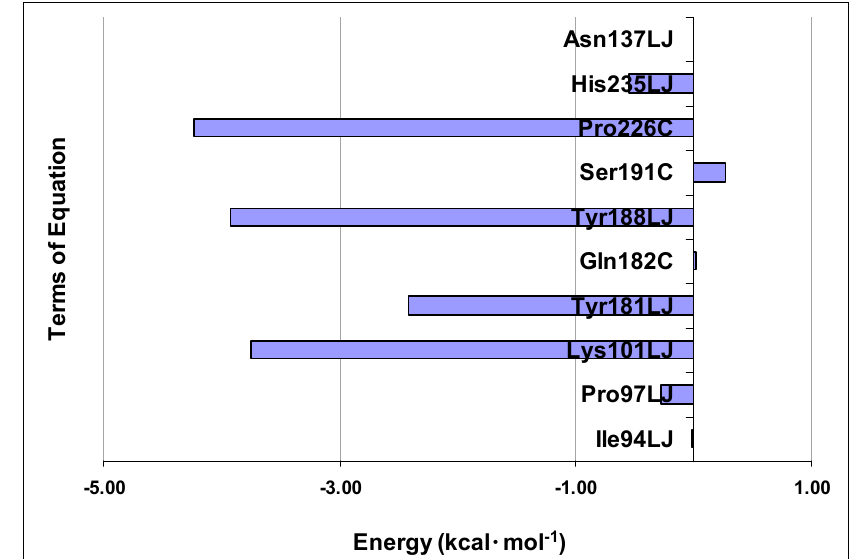
Figure 6. Average interaction energies (kcal·mol − 1 ) of compounds 1 – 74 with each of the selected terms in accordance with Eq.E (DB-I)